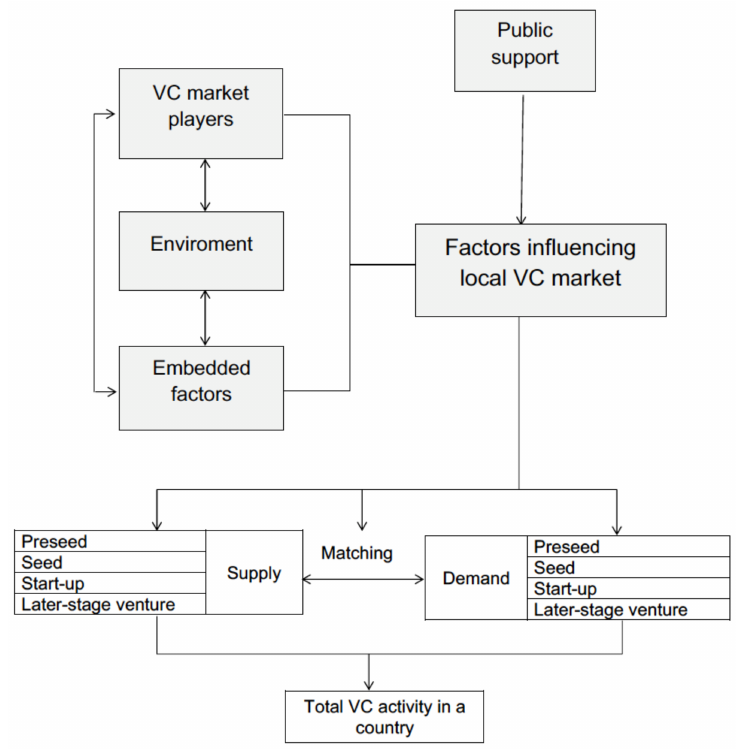
Figure 6. Conceptual model of VC market activity development